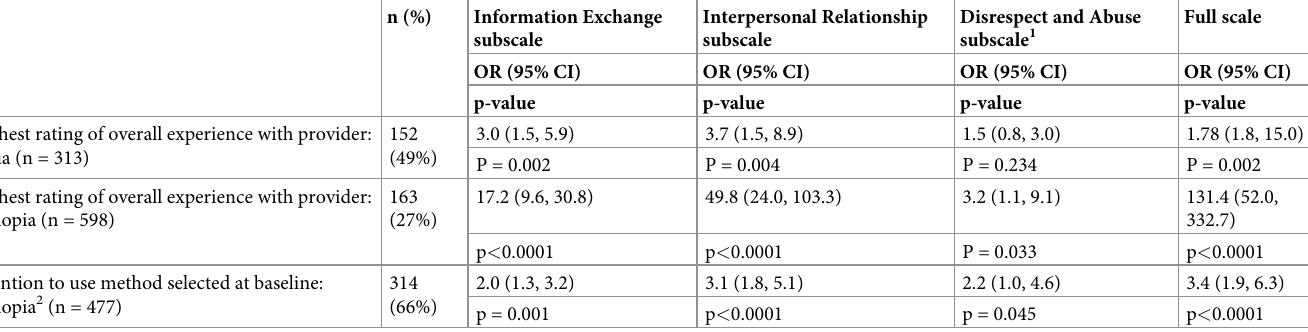
Table 4. Convergent validity results from logistic regression predicting the odds of related variables based on continuous 1 QCC-India and QCC-Ethiopia scale scores. n